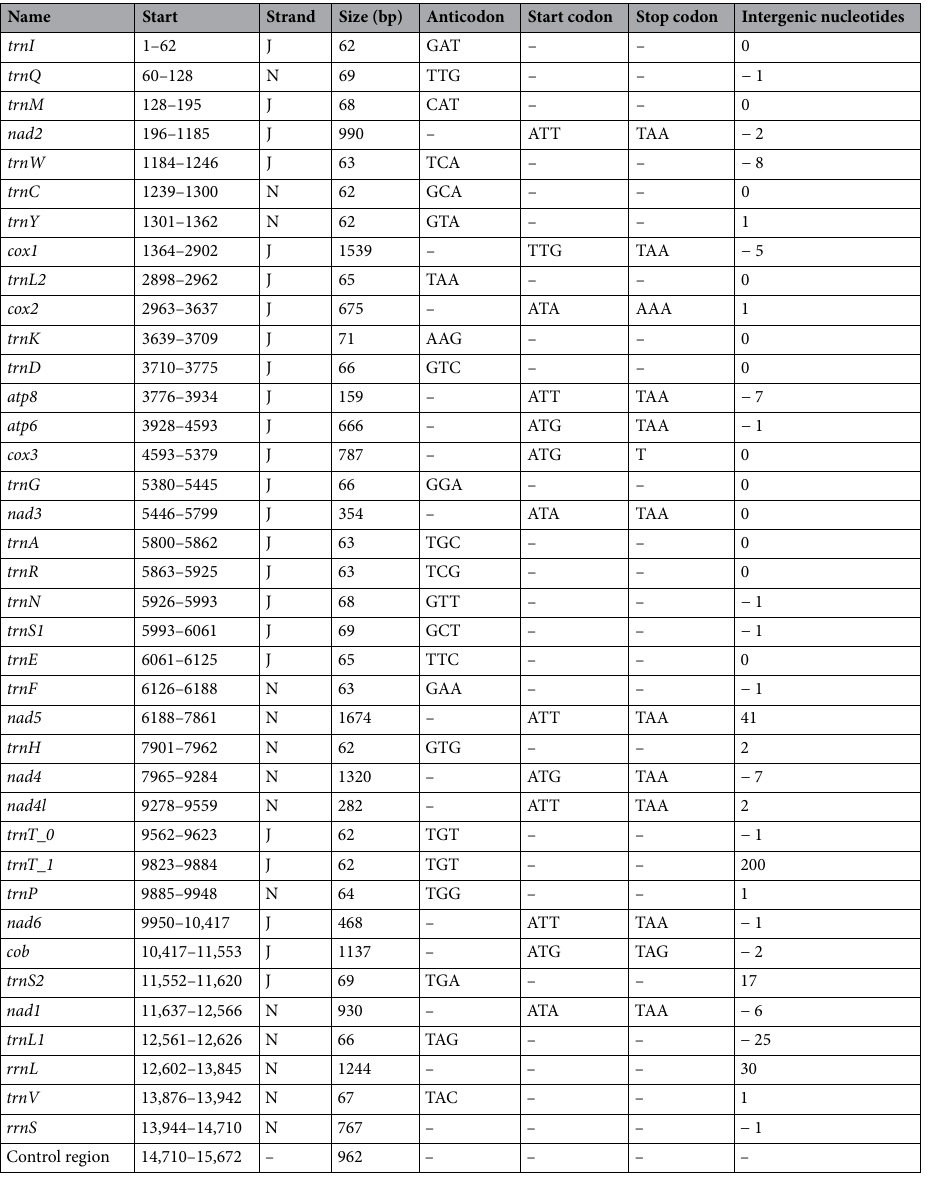
Table 2. Mitochondrial genome organization of O. laetus. J majority strand, N minority strand, − ve overlapping genes, + ve intergenic